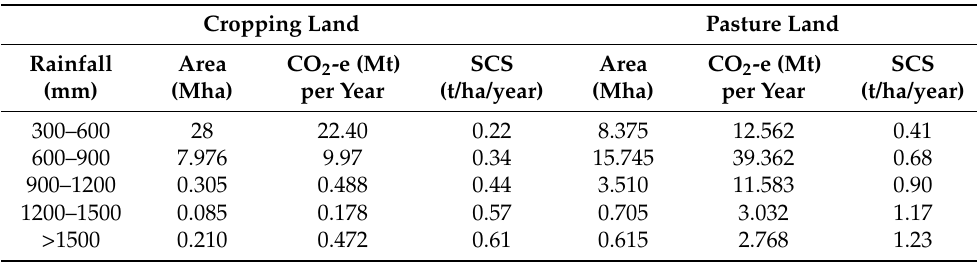
Table 2. Potential carbon sequestration in Australian cropping and pasture land according to rain- fall